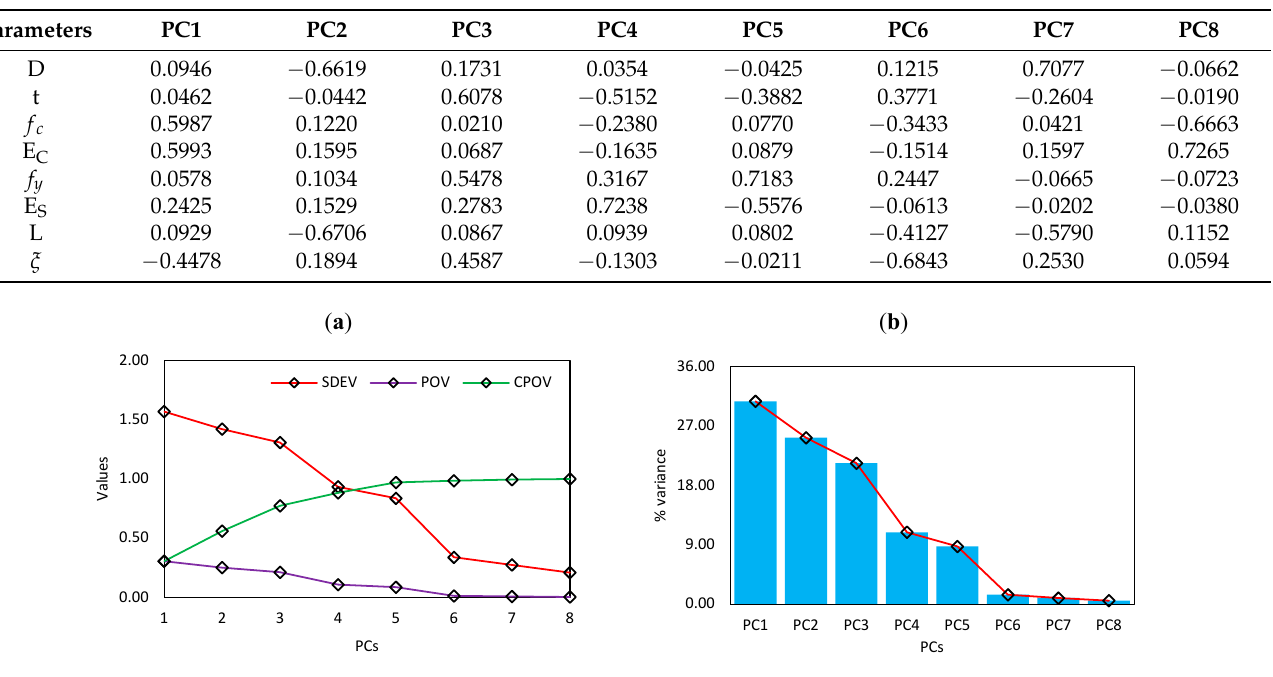
Table 3. Rotations of PCs.